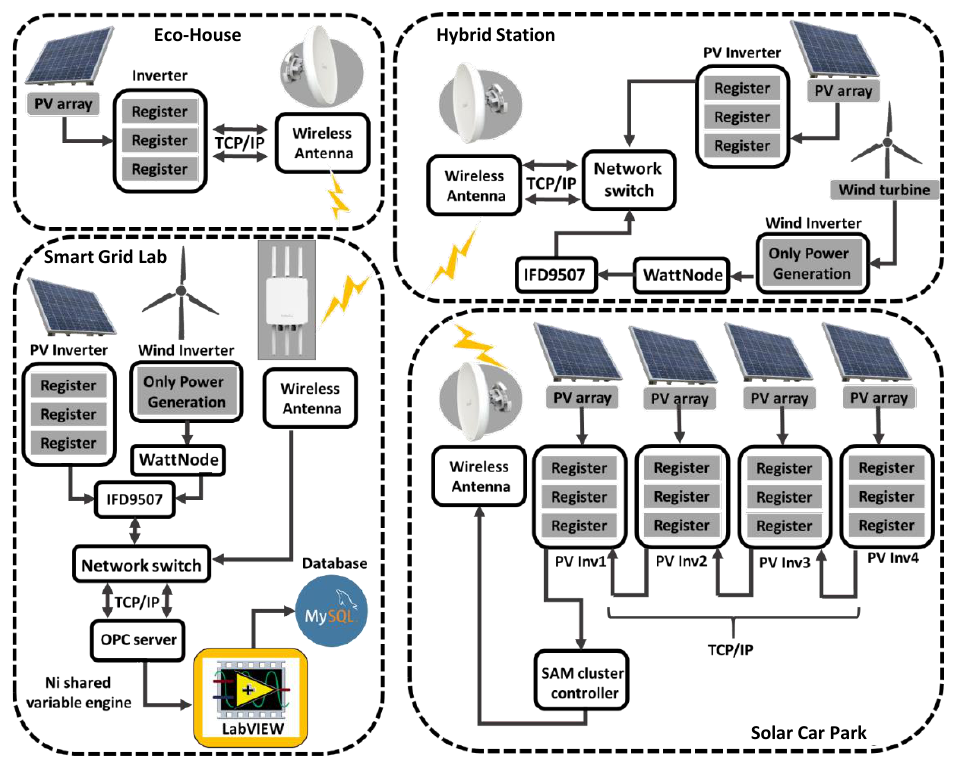
Figure 8. The layout of the real-time monitoring system. Notice that only the Smart Grid Lab and Hybrid Station include a wind turbine in their DERs. All locations communicate with the server through a bidirectional communication channel.